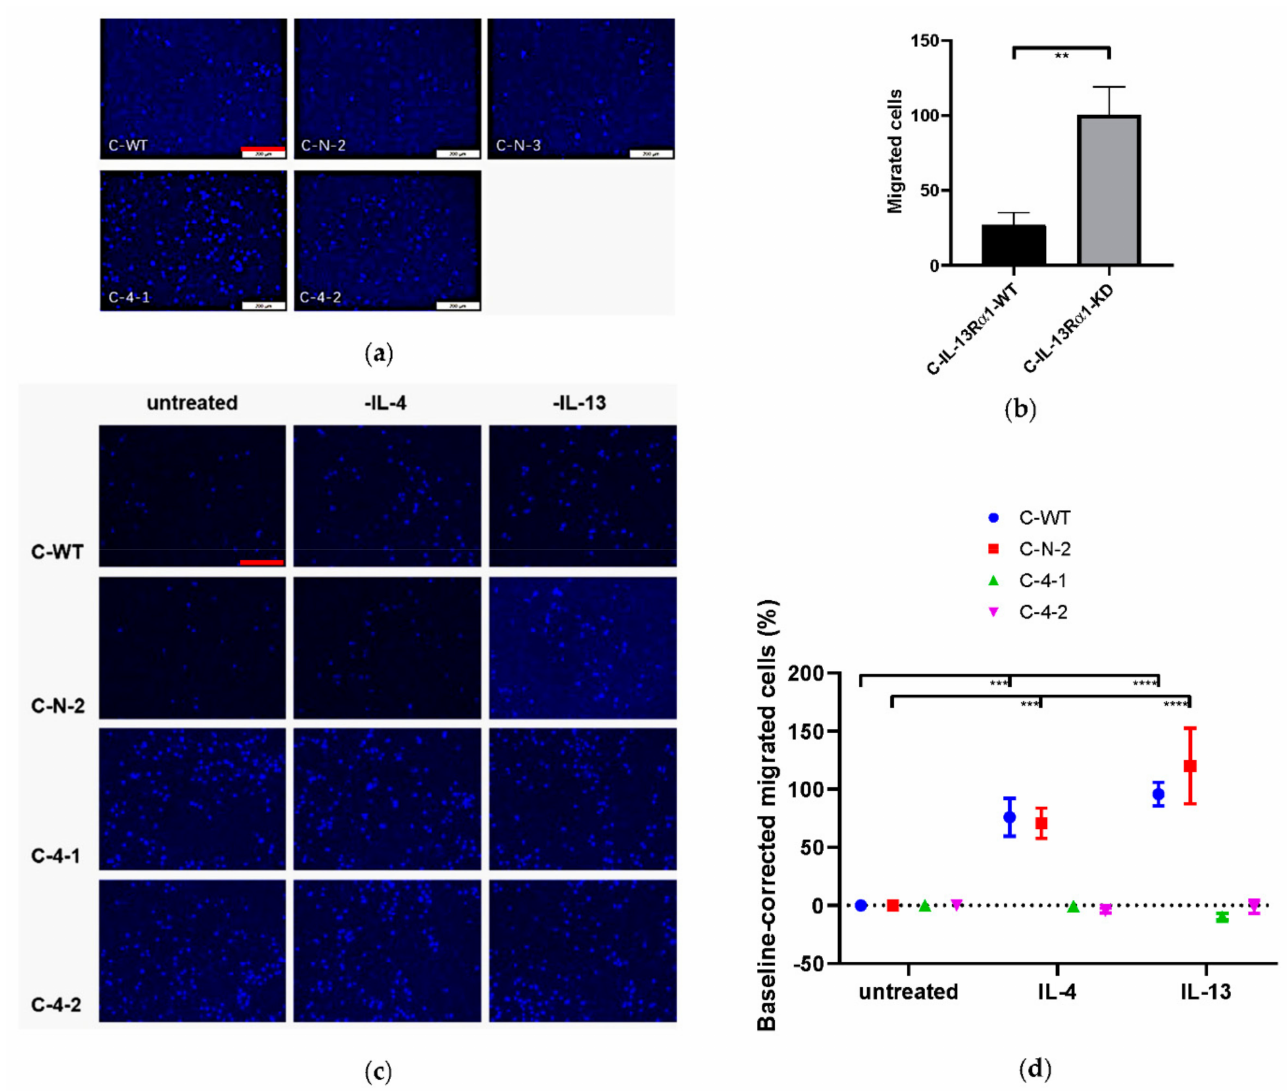
Figure 6. Directed migration in the modified Boyden-Chamber-Assay. ( a , b ) Effect of IL-13R α 1- downregulation on cell migration. ( a ) Representative pictures of C-WT, C-N-2, C-N-3, C-4-1 and C-4-2 show DAPI-labelled migrated cells within 24 h. 4 pictures were taken from each membrane